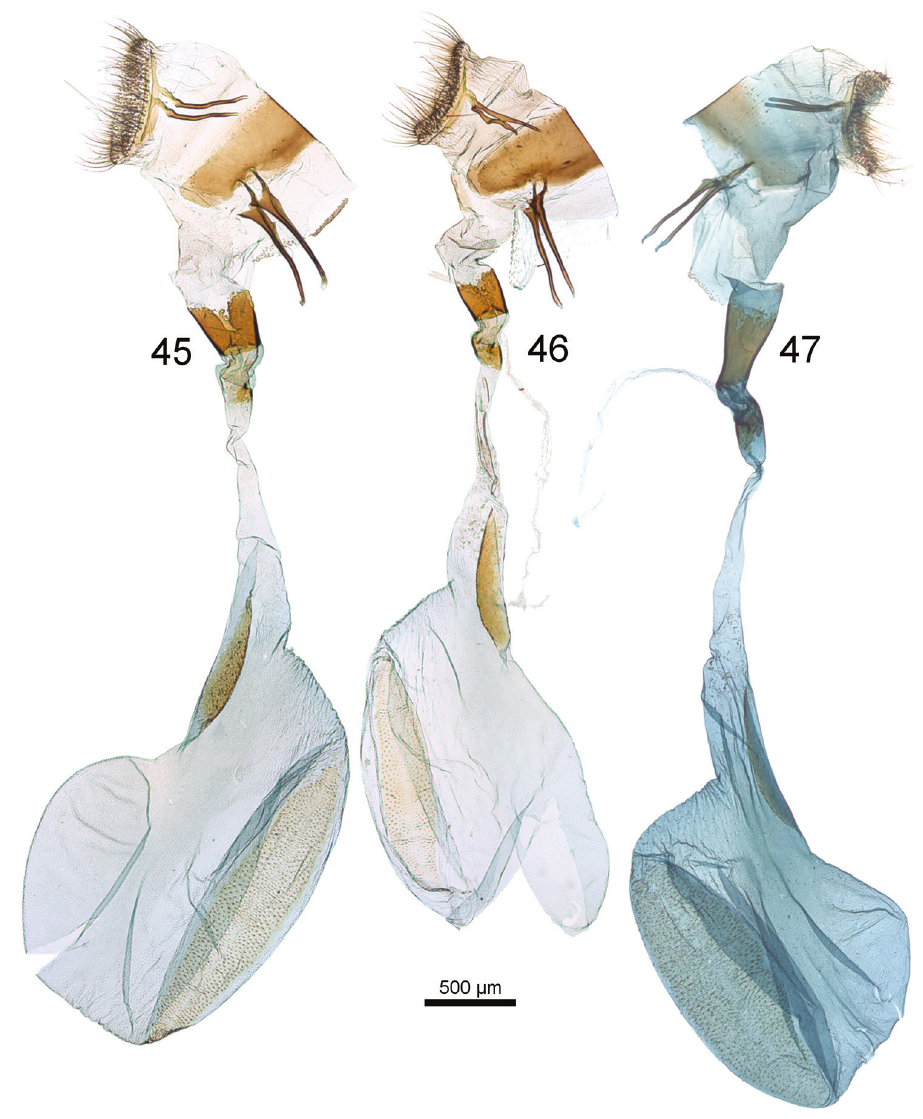
Figures 45–47. Female genitalia of Udea species. 45 U. austriacalis (Mally prep. 1047) 46 U. donzelalis (Mally prep. 1023) 47 U. altaica (Mally prep. 1084). somewhat constricted, apical half narrowed to a pointed, ventrad curved claw; right posterior phallus apodeme forming a sclerotised spatulate lobe with a central raised ridge bearing two small, laterally protruding teeth at its posterior end, sometimes with one or two additional, much smaller teeth posterior to the larger ones. Female genitalia. Unknown. Immature stages.